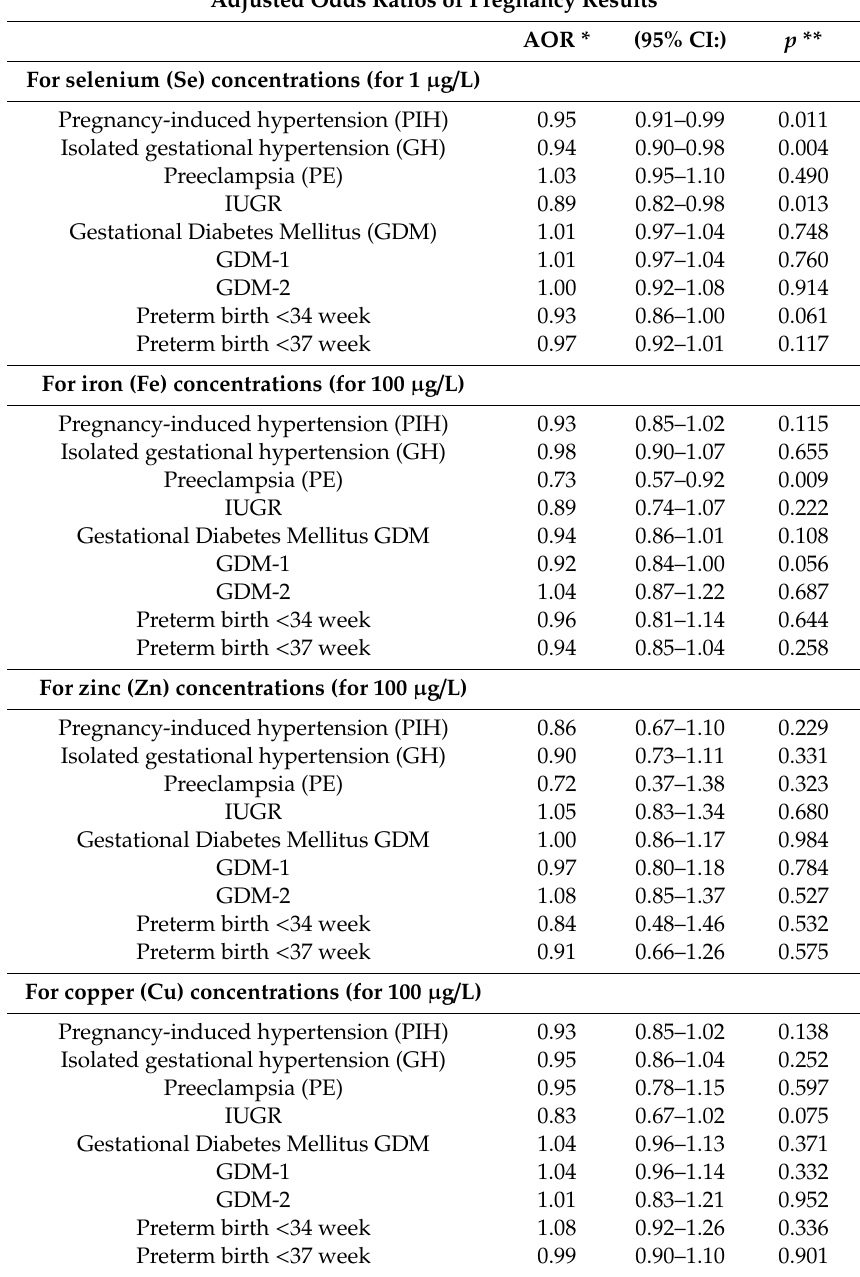
Table 6. The adjusted odds ratios of pregnancy results for levels of